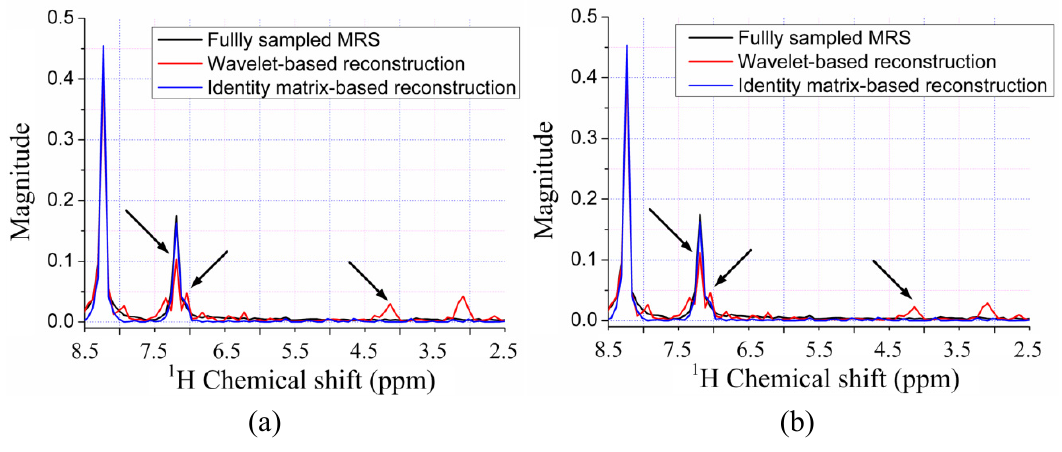
Figure 10. 1D slices along the indirect dimension for the chemical shift of 8.2 ppm ( a – c ) norm; or 7.2 ppm ( d ) in the direct dimension. ( a ) Spectra reconstructed with IST-based ℓ 1 norm; ( c ) spectra reconstructed with ( b ) spectra reconstructed with PSOCA-based ℓ 1 norm; ( d ) spectra reconstructed with PSOCA-based ℓ PSOCA-based ℓ 0.5 0.5